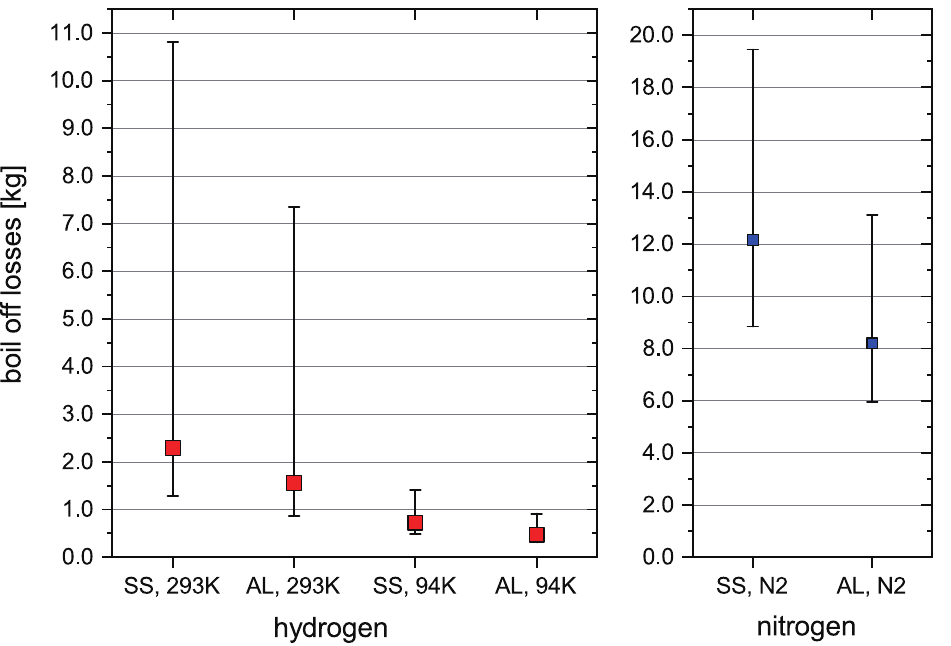
Figure 4. Boil-off losses for hydrogen and nitrogen (analytical validation). Table 3. Approximation of ∆ T ins .